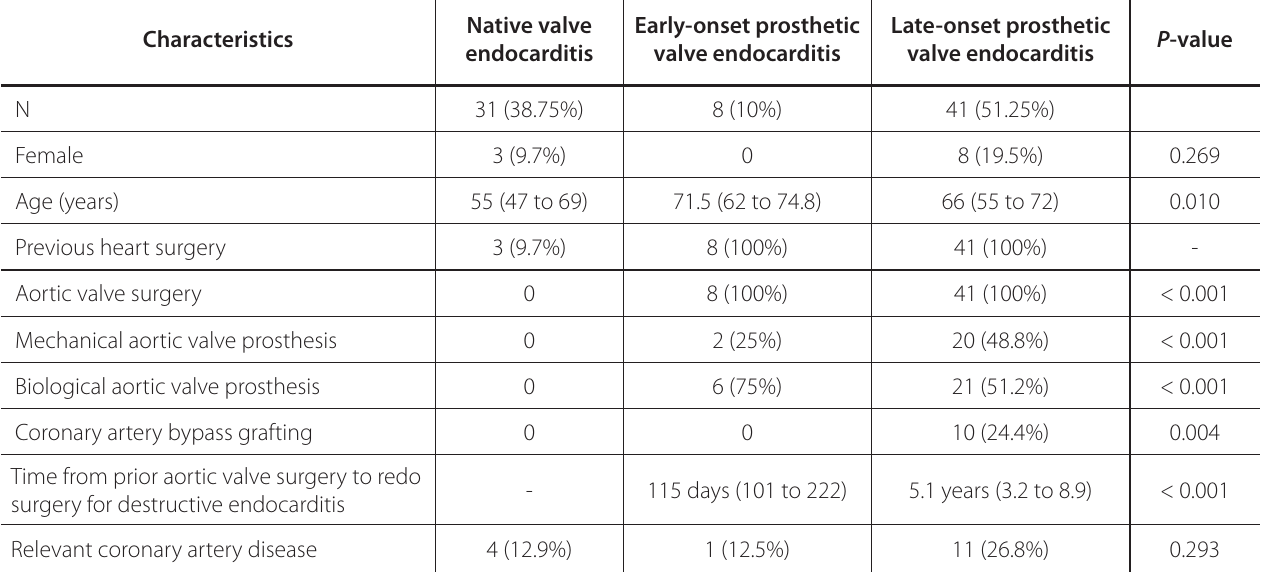
Table 1 . Preoperative characteristics and comorbidities.